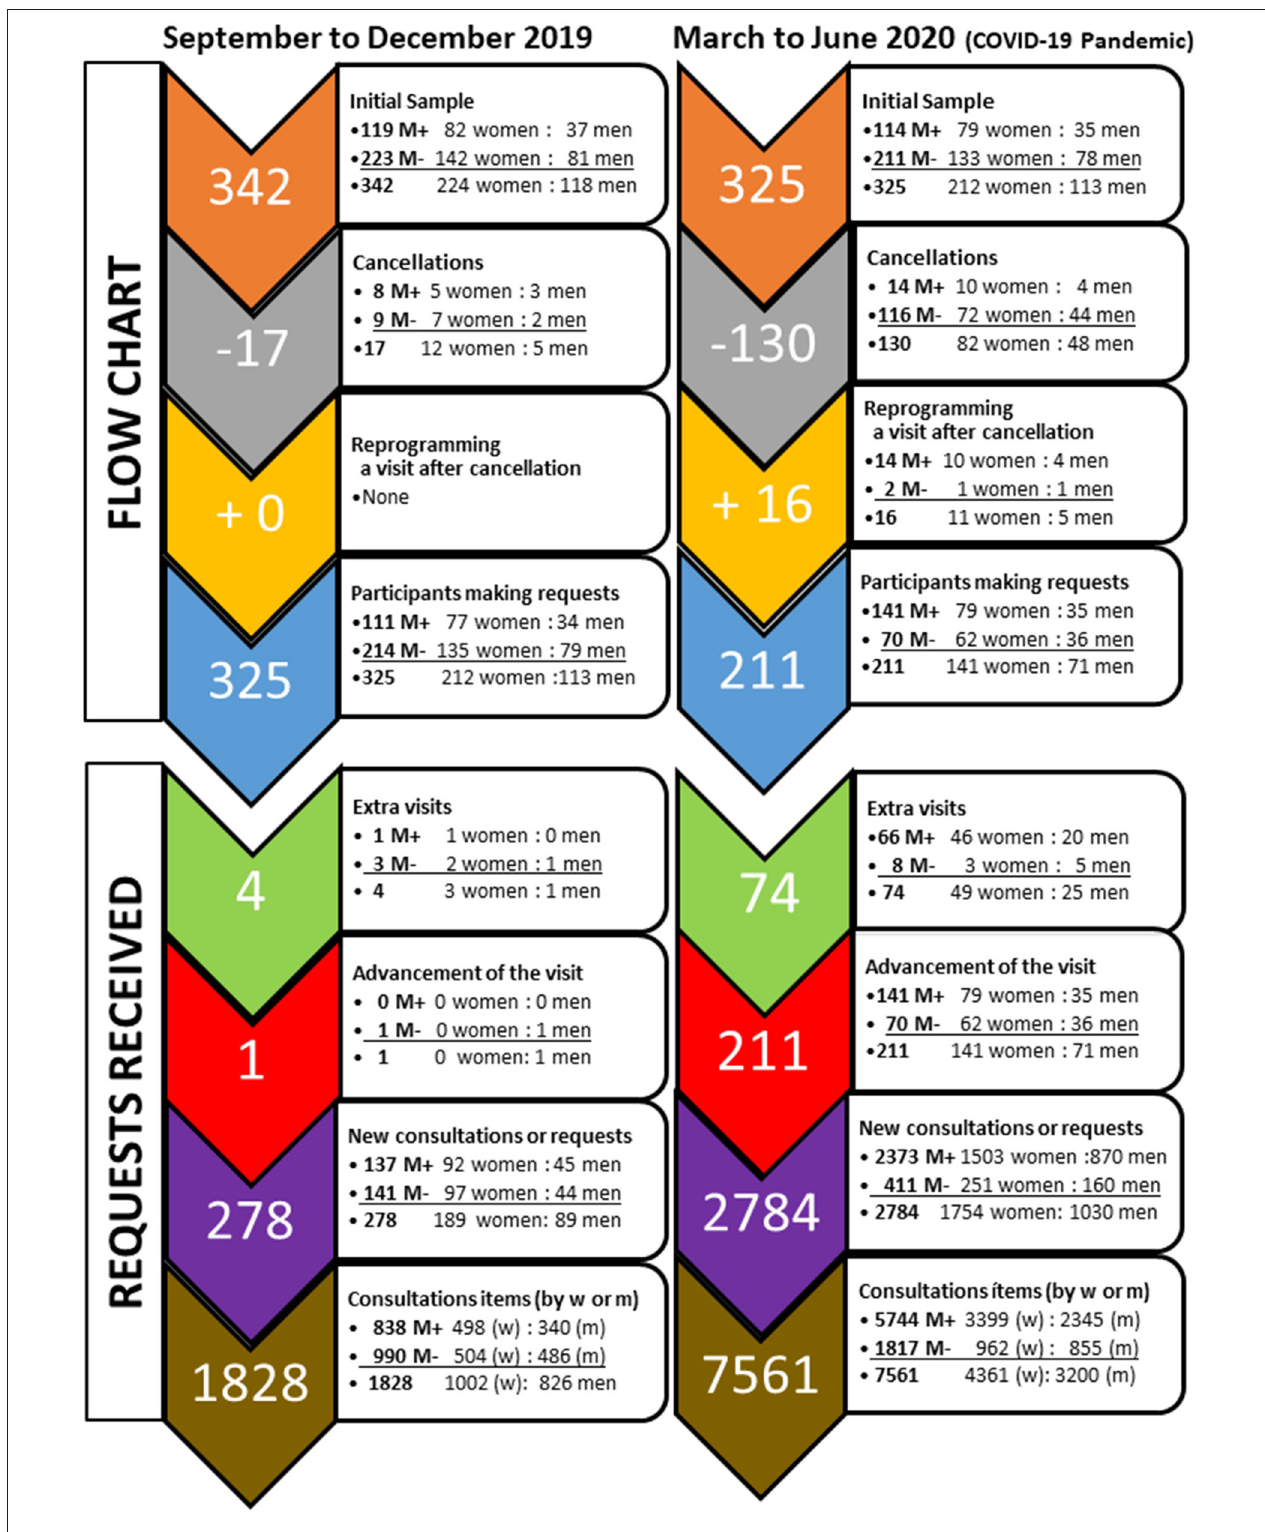
FIGURE 1 | Flow chart of participants in the two periods studied and number of requests received in the medical psychology center.